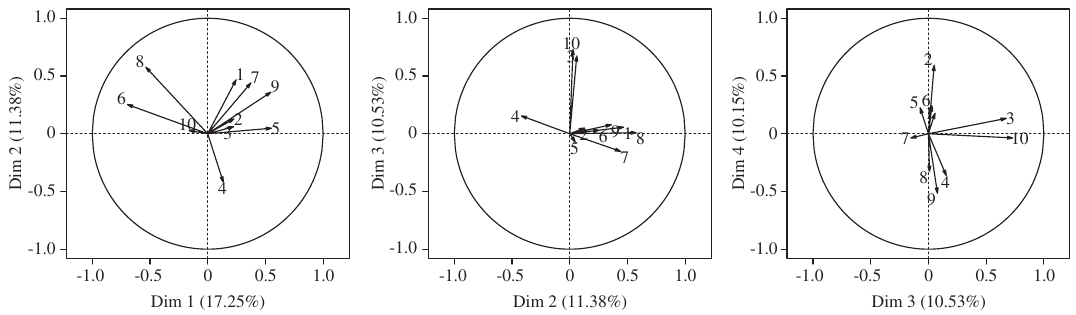
Figure 10. Coefficient Circles of Single-Peaked